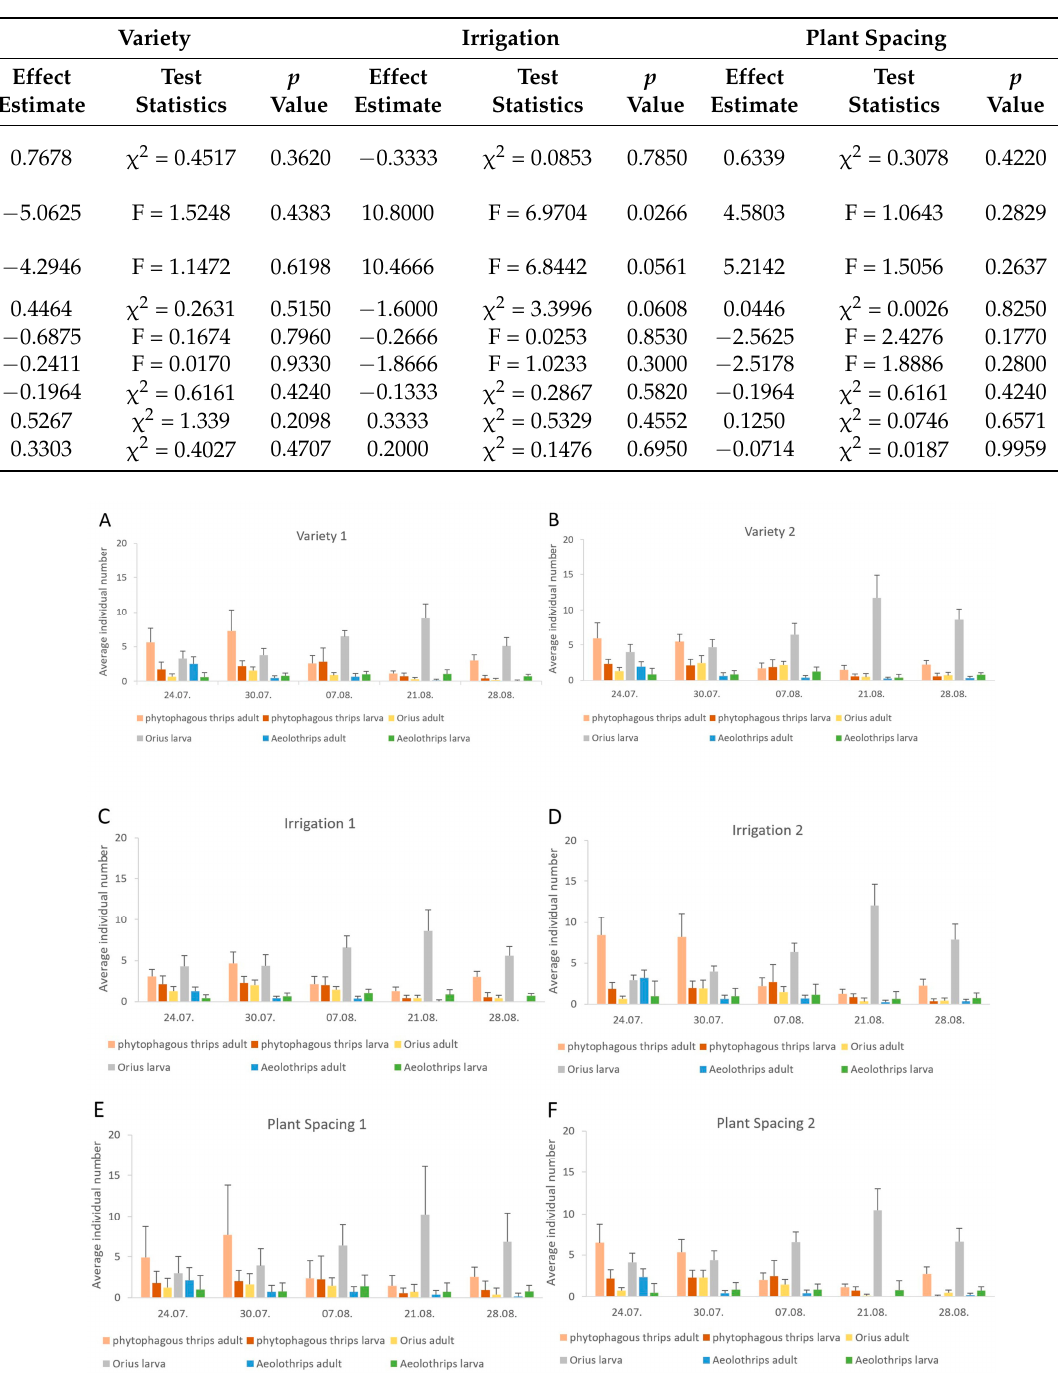
Table 3. Effects of variety, irrigation level and plant spacing on the insect abundance in chili flowers in 2021. Residual degrees of freedom were 178 in all tests.